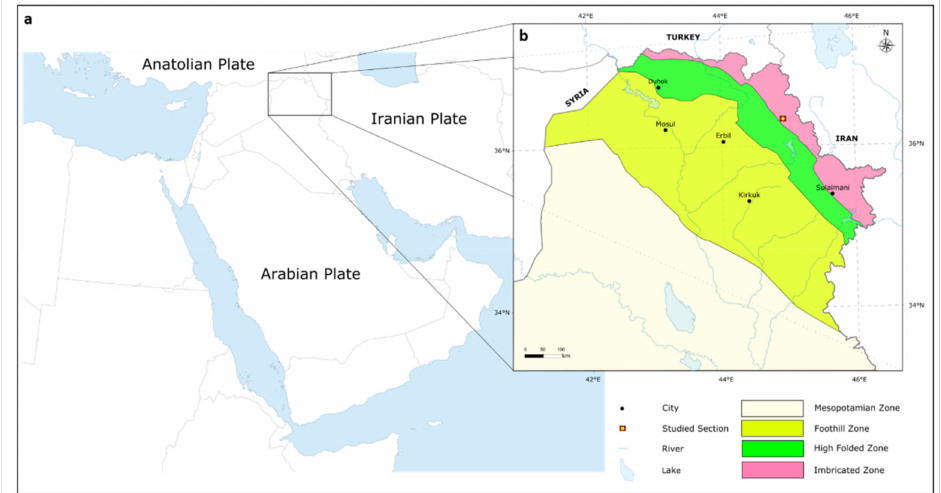
Figure 1. ( a ) Location of the study area in northeastern Iraqi Kurdistan within the Arabian plate. ( b ) Geological map of Northern Iraq showing the study area and the structural zones of the Zagros Basin/Zagros Fold